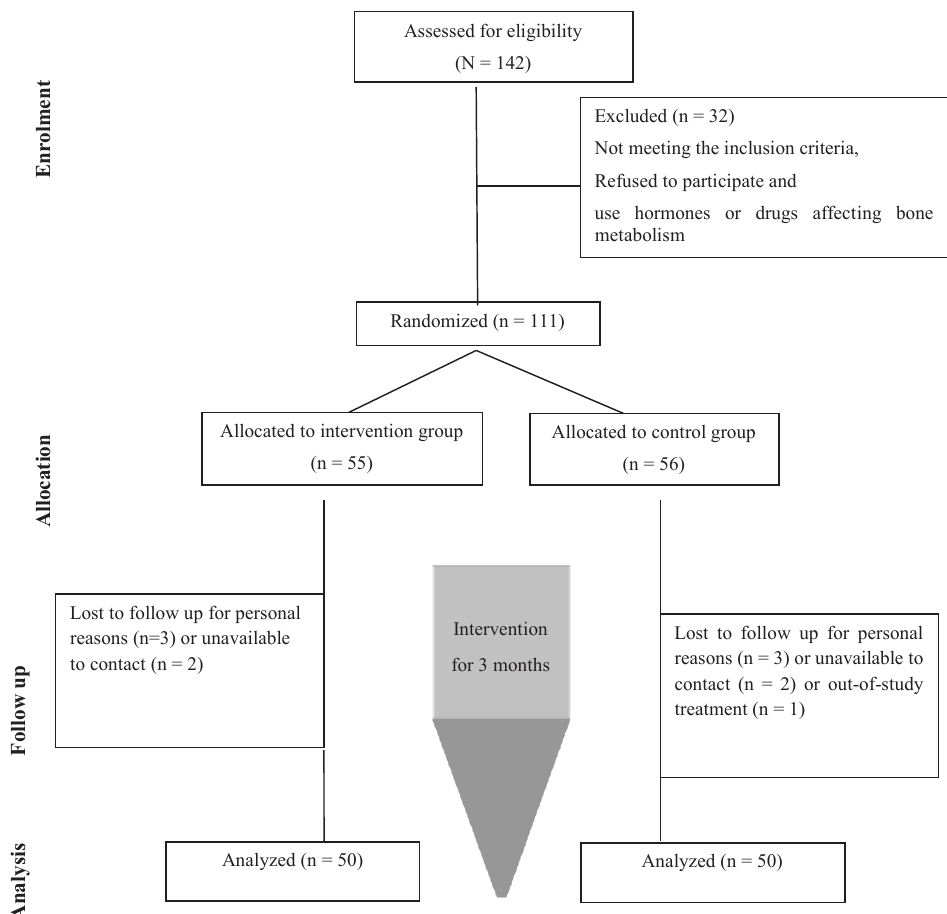
Figure 1. Algorithm of study participants in the two